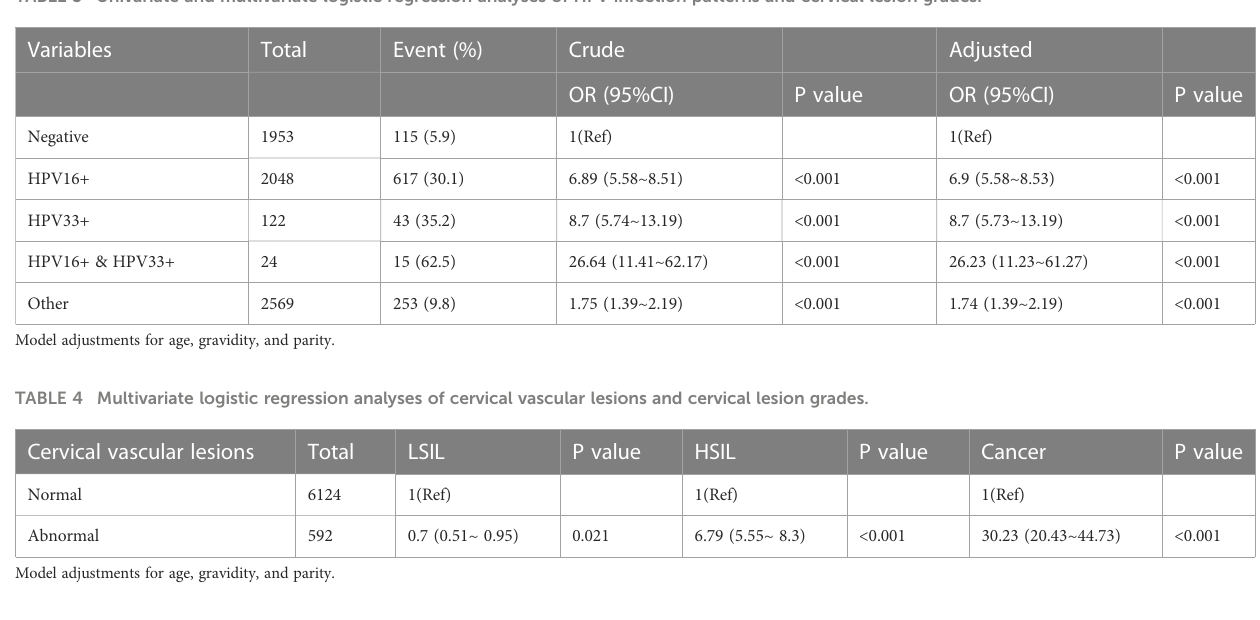
TABLE 3 Univariate and multivariate logistic regression analyses of HPV infection patterns and cervical lesion grades.